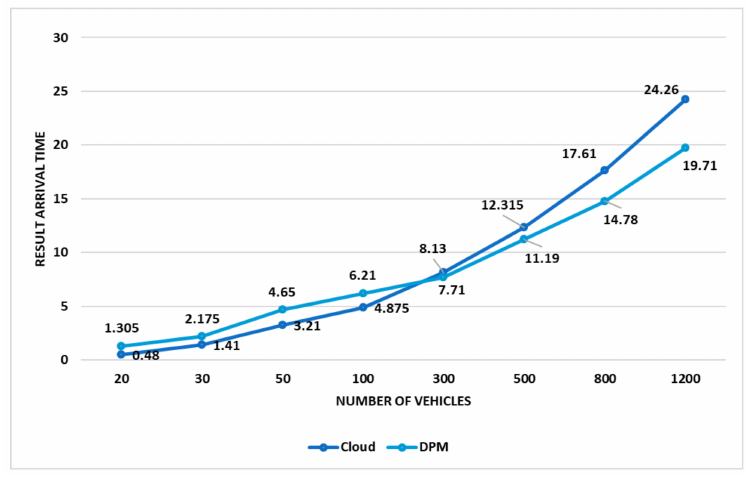
Figure 15. The comparison of an average response time about a self-diagnosis request.